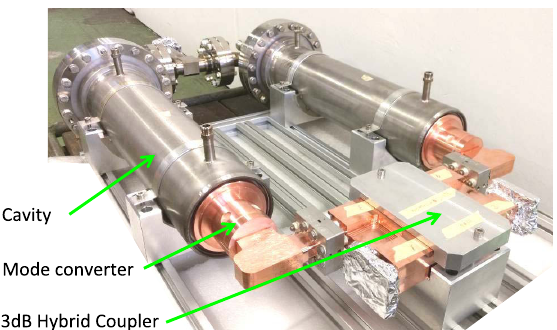
FIG. 2. SLED-I pulse